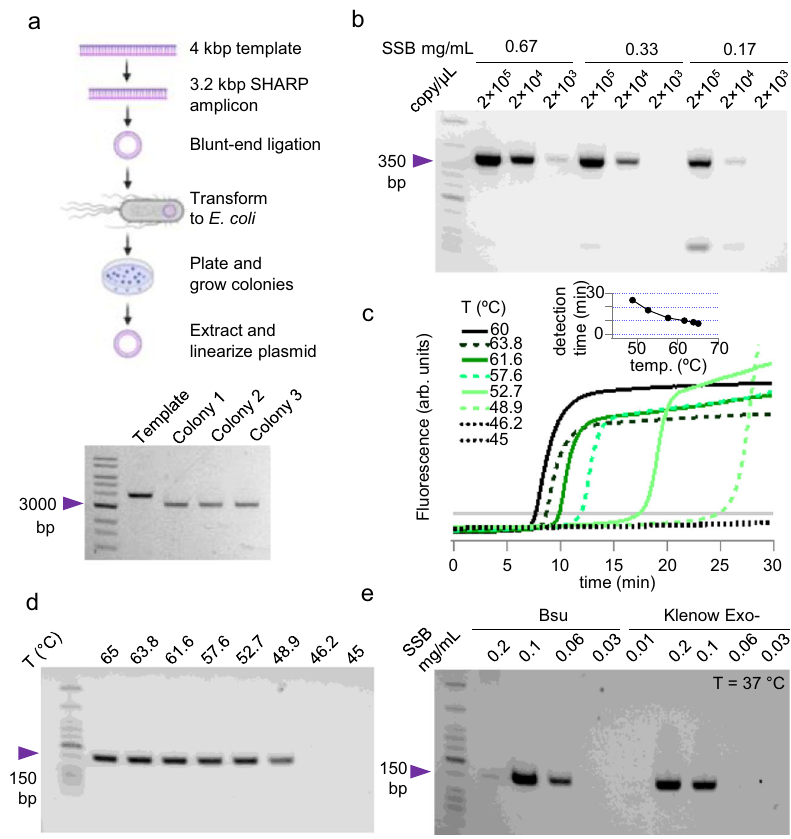
Fig. 5 | Applications of SHARP. a Transforming SHARP-made plasmid to E. coli . b SHARP ampli fi es sequence prone to forming secondary structure (CAG repeats) atdifferentSSBconcentrations. c SHARPkineticscurvesatdifferenttemperatures, inset shows detection times. d SHARP productat different temperatures. e SHARP